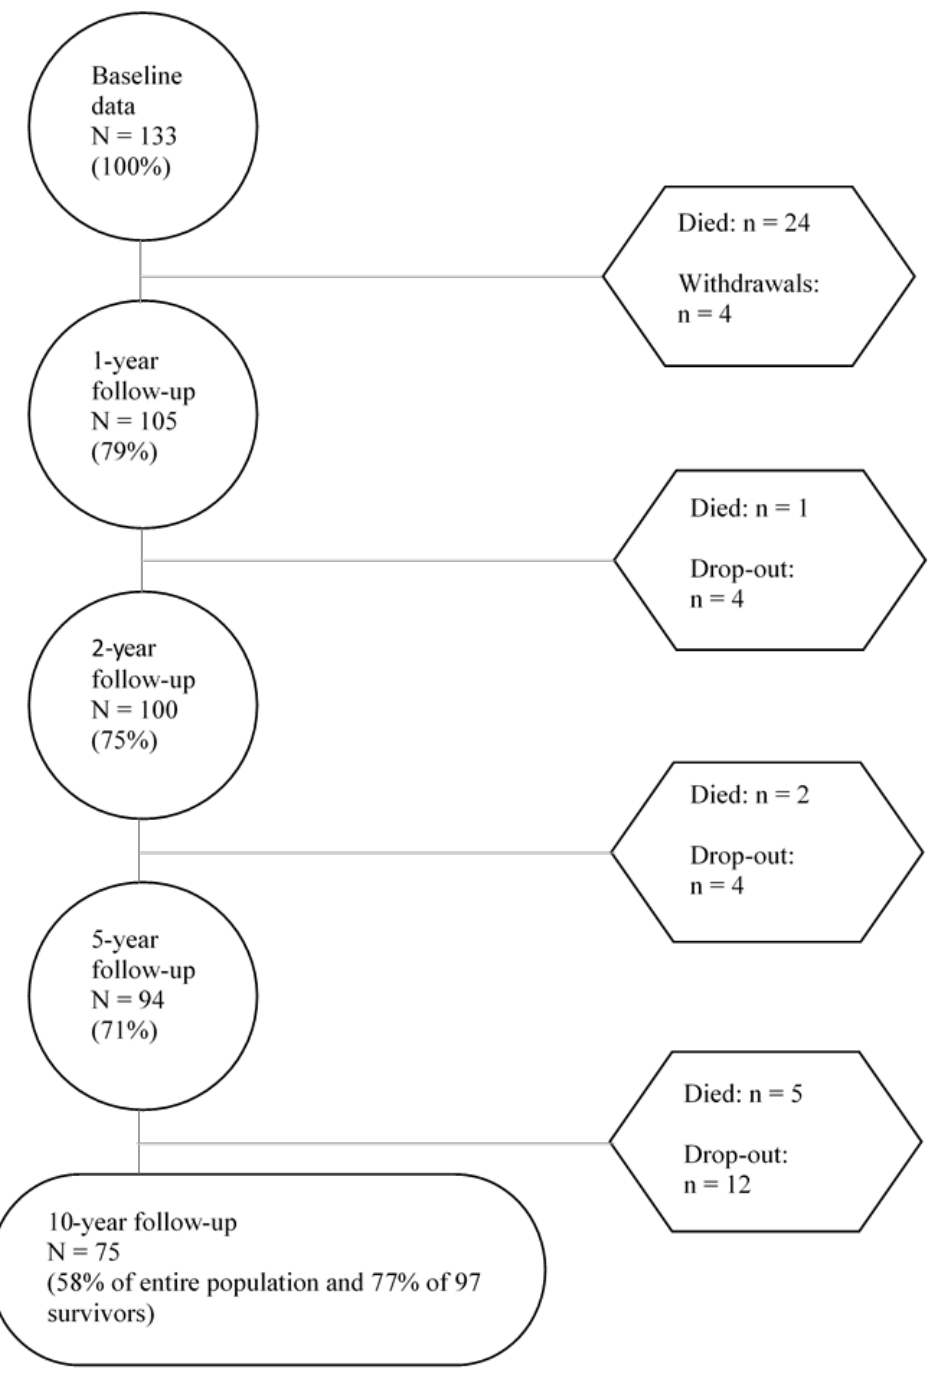
Figure 1. Flowchart depicting baseline and follow-up data through 10-years.